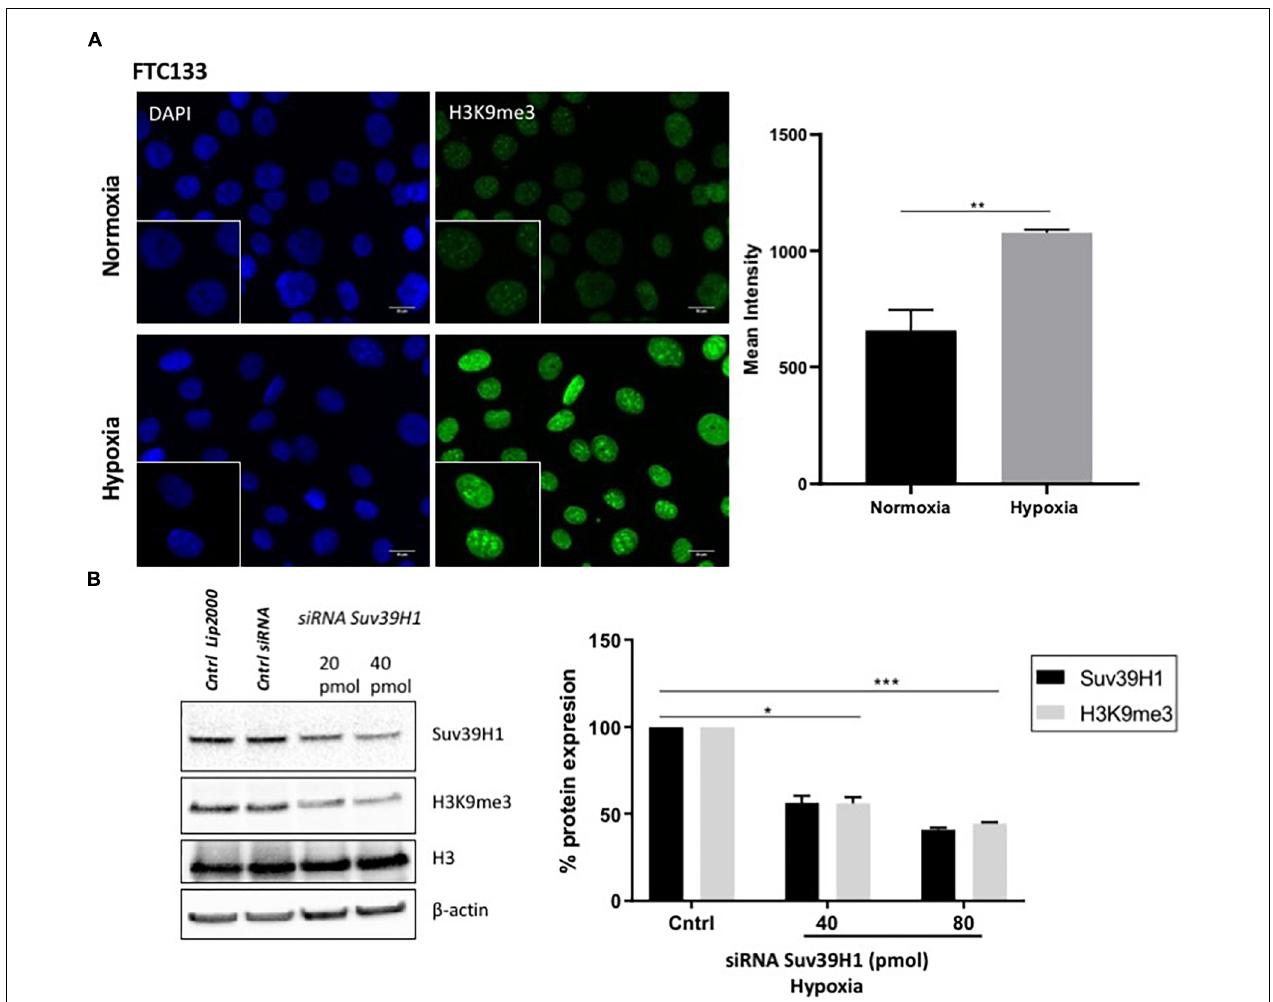
FIGURE 2 | H3K9me3 upregulation in hypoxia is Suv39H1 dependent. FTC133 cells were incubated for 18 h in normoxic (21% O 2 ) or hypoxic (0.1% O 2 ) conditions then fixed and stained for H3K9me3 (green) and DAPI (blue) (A) . The graph represents H3K9me3 mean fluorescence intensity for each condition. FTC133 cells were transfected with Suv39H1 siRNA or control siRNA and incubated in hypoxia for 18 h. Cells were lysed and analyzed by Western blot. Densitometry analysis of Suv39H1 and H3K9me3 protein level is represented in the graphs as a percentage of protein expression by standardizing the levels of Suv39H1 with β -actin and control siRNA and the levels of H3K9me3 with the total amount of H3 and the control siRNA (B) . Three independent experiments were performed and the bar represents the mean ± SEM. * p ≤ 0.05, ** p ≤ 0.01, *** p ≤